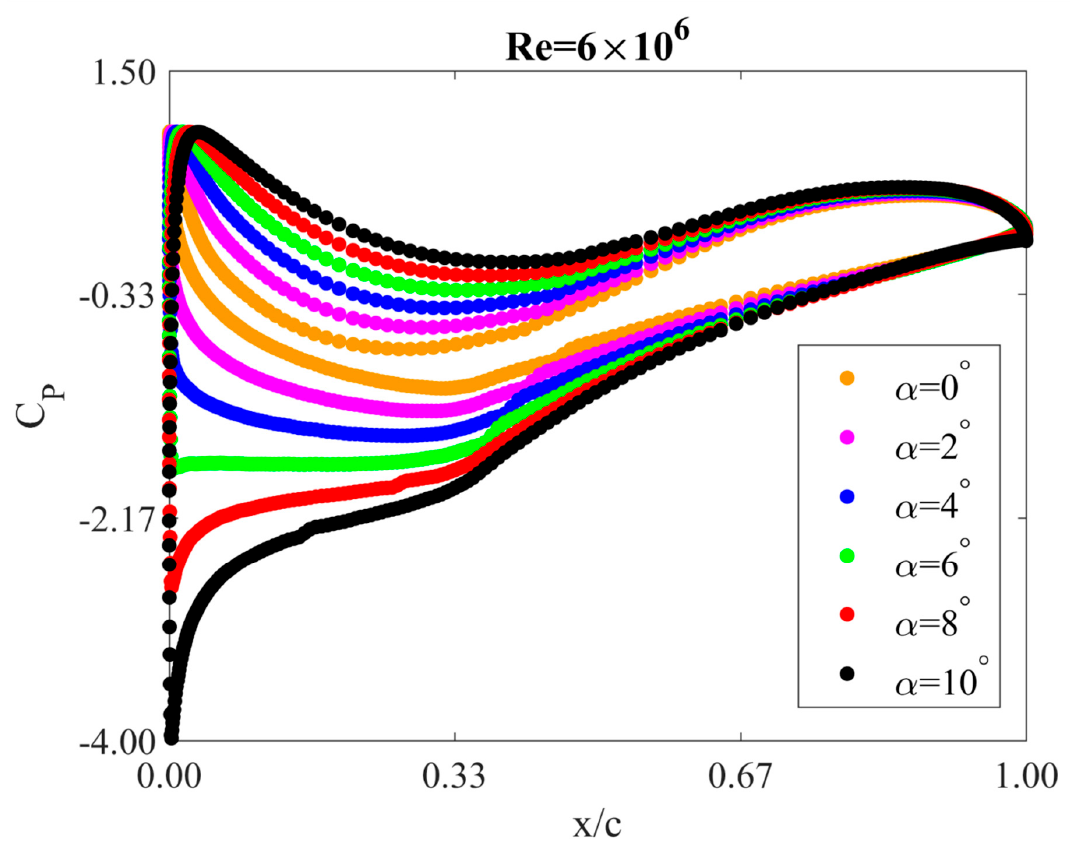
Figure 10. Static pressure coefficient for Reynolds number of 6 × 10 (cid:2874) . The influence of the angle of attack.